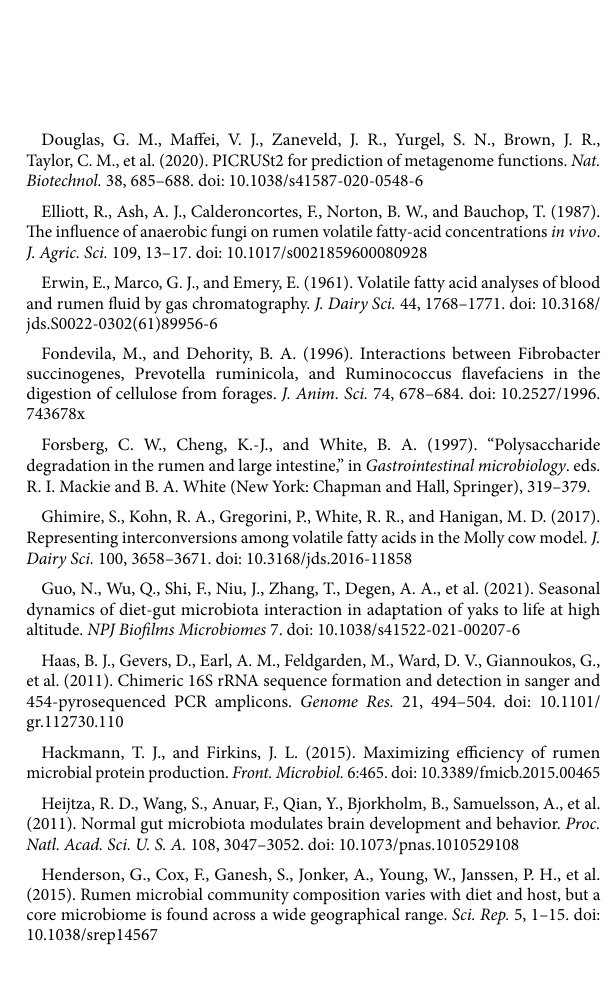
SUPPLEMENTARY FIGURE S1 Amplicon sequence variants (ASV) of rumen microbiota in GSG, NSG and SG. (A) Bacteria. (B) Fungi. (C)Archaea. SUPPLEMENTARY FIGURE S2 Classification of the rumen microbial composition at the phylum level across the different nutrient simulations in different grazing patterns. (A) Bacteria. (B) Fungi. (C) Archaea. (D) Bacterial phylum with significant changes under various nutrient simulations. (E) Fungal phylum with significant changes under various nutrient simulations. Asterisks indicate significant difference between the three groups (* P ≤ 0.05; ** P ≤ 0.01). SUPPLEMENTARY FIGURE S3 Linear discriminant analysis (LDA) of rumen microbial communities.